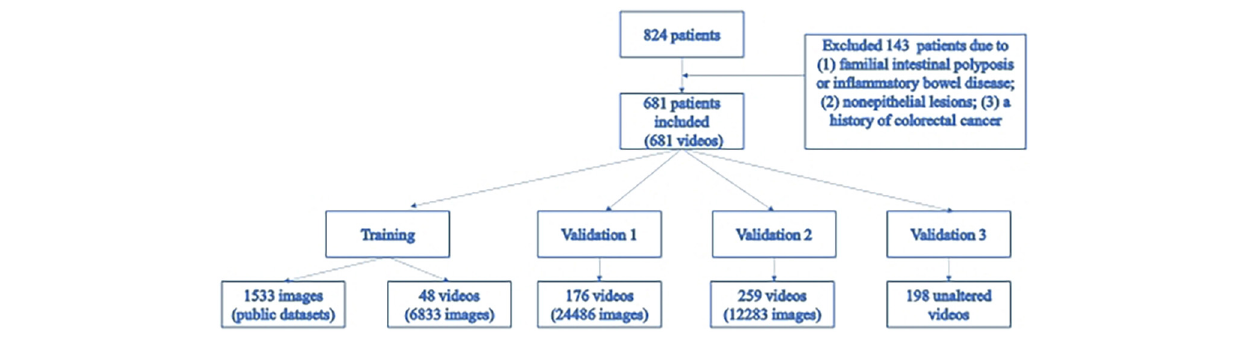
FIGURE 2 | Flowchart of the